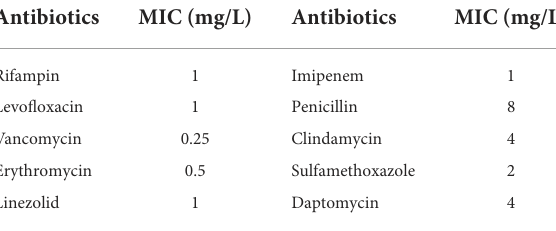
TABLE 2 Antibiotic susceptibility test for Rhodococcus equi